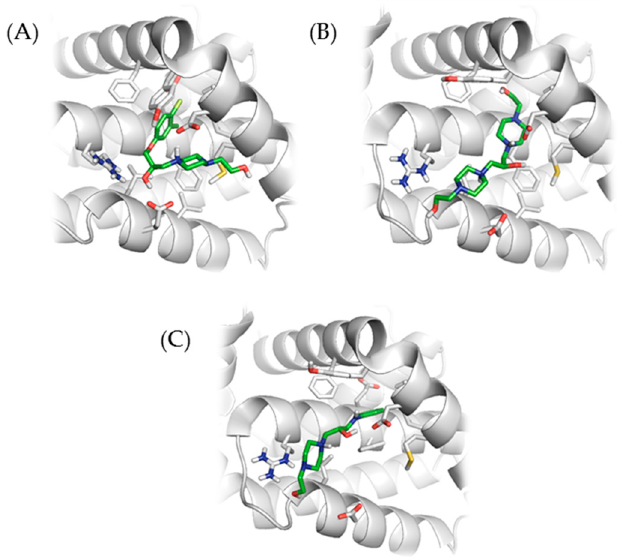
Figure 1. Interaction of selected compounds with Bcl-2 protein. ( A ) Interaction of compound 4 with Bcl-2: ionic interaction of protonated piperacilin nitrogen with Asp108, hydrogen bond of hydroxyl oxygen with Arg143, hydrophobic interaction of chlormethylphenyl part with the pocket Leu134, Phe101, Tyr105, Phe109, Met112, Phe150, and Val130. ( B ) Interaction of compound 8 with Bcl-2: ionic interaction of protonated piperacilin nitrogen with Asp108, hydrogen bonds Arg143 with hydroxyl oxygen. ( C ) Interaction of compound 10 with Bcl-2: hydrogen bonds of aniline group and of hydroxyl group with Asp108, and of piperacilin nitrogen and hydroxyl oxigen with Arg143, hydrophobic interaction of phenyl part with the pocket Leu134, Phe101, Tyr105, Phe109, Met112, Phe150, and Val130.